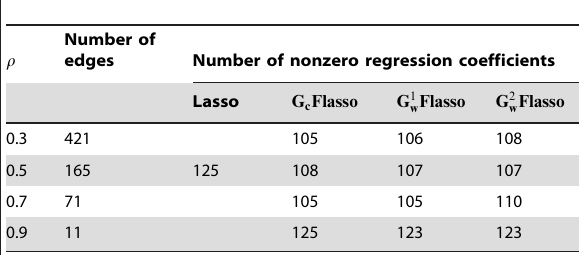
Table 1. Summary of results for the association analysis of the asthma